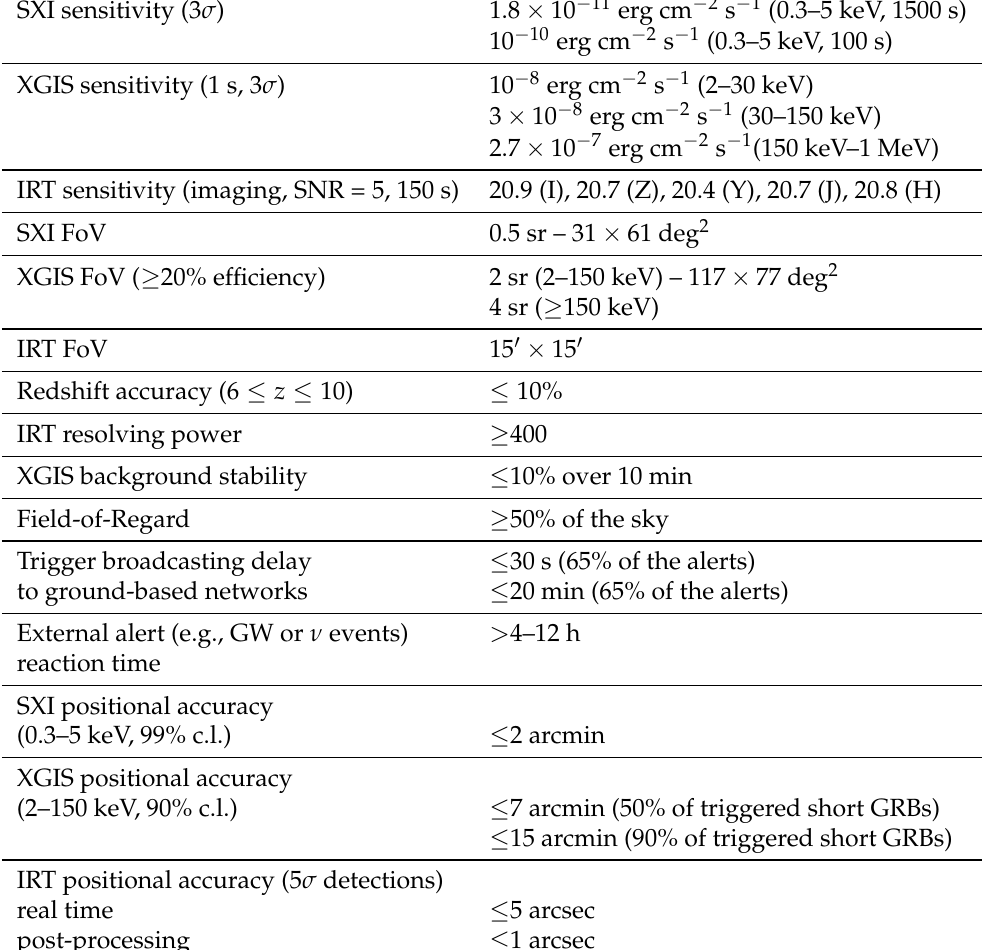
Table 1. Key science performance requirements of THESEUS 1 . The sensitivity requirements assume a power-law spectrum with a photon index of 1.8 and an absorbing column density of 5 × 10 20 cm − 2